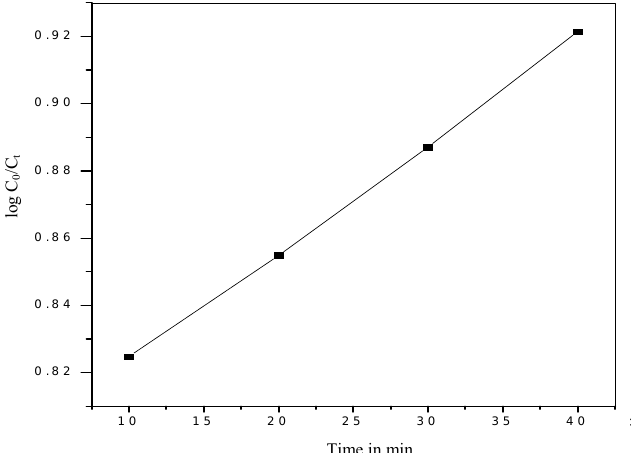
Figure 5. Natarajan Khalaf plot for the adsorption of copper ion by CBC [Cu]=30 mg/L; temp=35 o C; contact time =60 min; adsorbent dose=25 mg/50